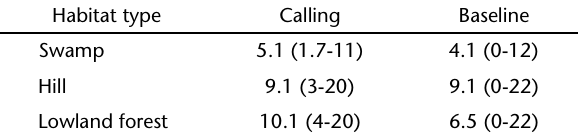
Table I. Average height from the ground (in meters) location of golden lion tamarins when emitting long calls and during baseline behavior (not calling) for each habitat type within the União Biological Reserve. Low-high values are shown in parentheses.